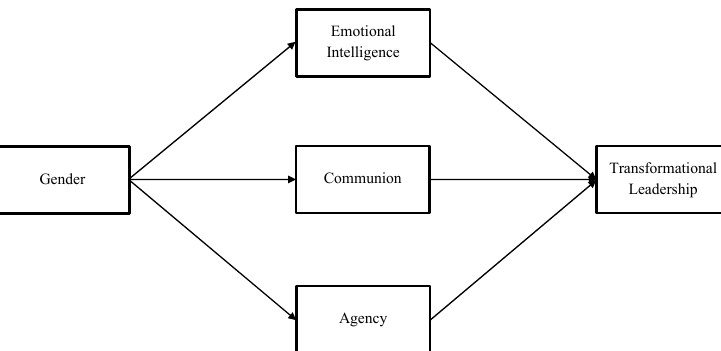
Figure 1. A Personality-Based Model of Female Leadership Advantage.